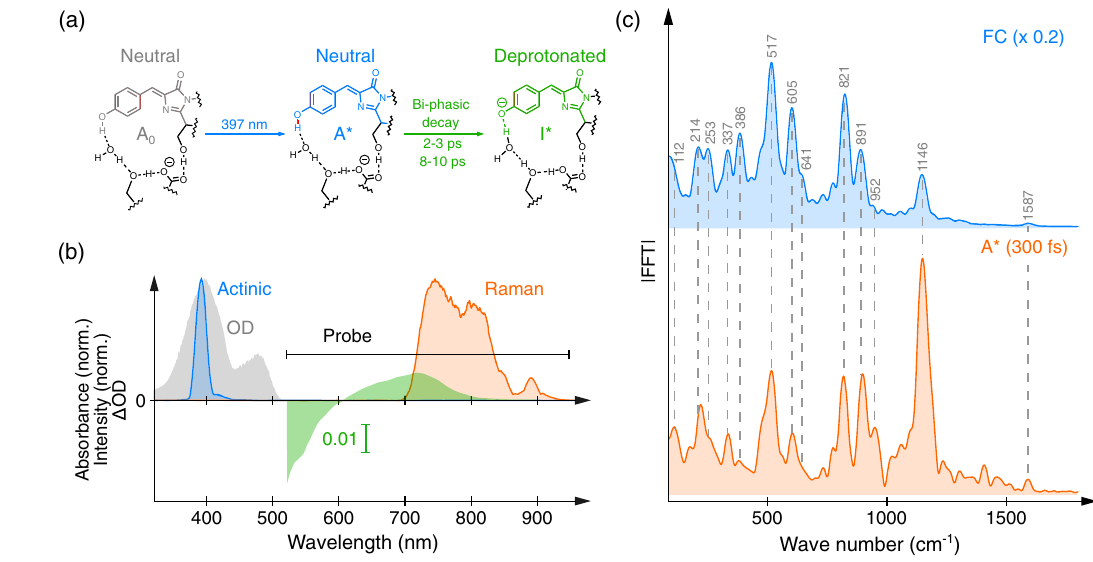
FIG. 2. Experimental characterization of wild-type GFP. (a) Photodynamics of GFP. Photoexcitation of the neutral A 0 chromophore at 397 nm prepares A*, which decays with biphasic dynamics (2 – 3 and 8 – 10 ps) to the fluorescently active deprotonated I* chromophore [59,60]. (b) Normalized absorption spectrum (gray) and transient absorption spectrum at 1 ps (green) and employed actinic and Raman pulse spectra (blue and orange). (c) Comparison of FC spectrum (blue) and A* Fourier amplitude spectrum binned in T 1 to 300 fs to average out any effect of oscillatory modulations along T 1 (orange). The absolute amplitude of the FC spectrum was scaled by 0.2 for clarity. Raman spectra were averaged over a probe wavelength region from 575 to 615 nm (stimulated emission), and coherent oscillations were Fourier transformed over a time delay of 1 ps (see Appendix C for further